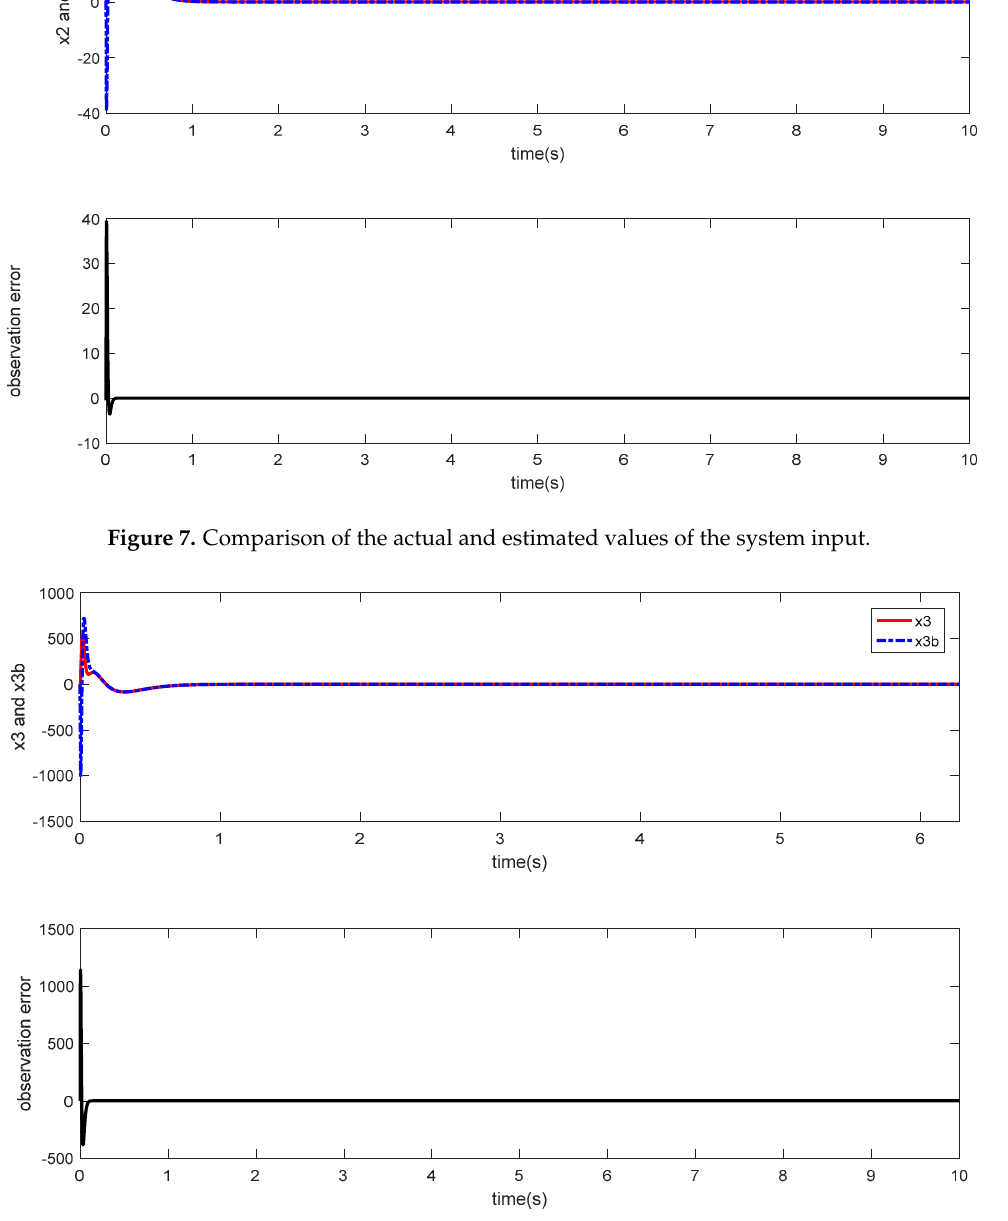
Figure 8. Comparison of the actual and estimated values of the system input.